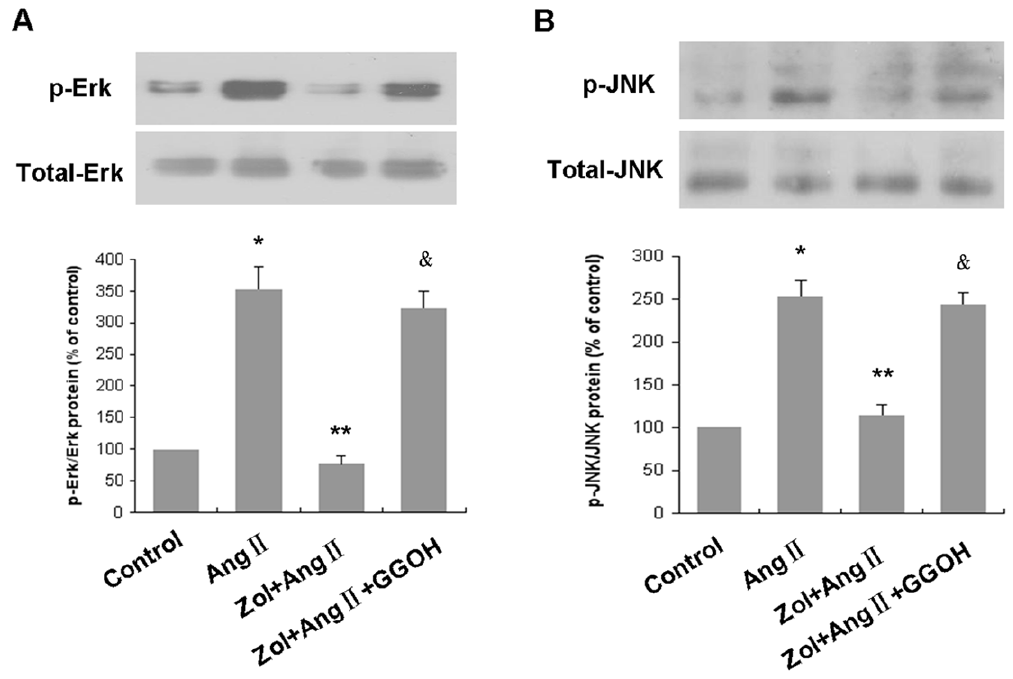
Figure 7. Role of RhoA suppression in Zol antiangiogenic effect. shRNA was used to silence RhoA gene expression. RhoA expression and EPC in vitro tube formation were investigated. A–B, RBD-RhoA proteins (upper panel) and the total amount of RhoA (middle panel) were detected by Western blot using monoclonal antibody against RhoA. b -actin was the endogenous control for each sample (lower panel). Values shown are representative of three independent experiments. Control shRNA group: * P , 0.01 vs. control group; &P , 0.01 vs. Ang II group; RhoA shRNA group: # P , 0.01 vs. control group; P , 0.01 vs. Ang II group; ** P , 0.01 for Control shRNA vs. RhoA shRNA group. C–D, Light and fluorescence micrographs showing typical tubules. Quantitative analysis of total length of the tubes formed on Matrigel for each experimental group was performed. The results are representative of three independent experiments. Control shRNA group: ** P , 0.01 vs. control group; &P , 0.01 vs. Ang II group; RhoA shRNA group: # P , 0.05 vs. Ang II group; * P , 0.05 for Control shRNA vs. RhoA shRNA